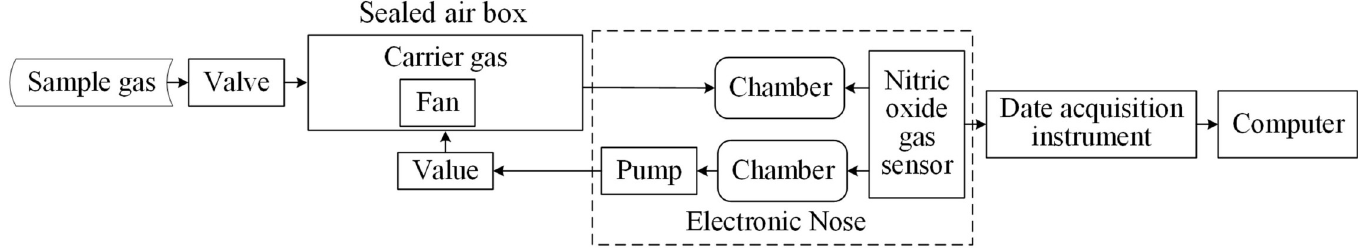
Fig 1. Block diagram of electronic nose detector.